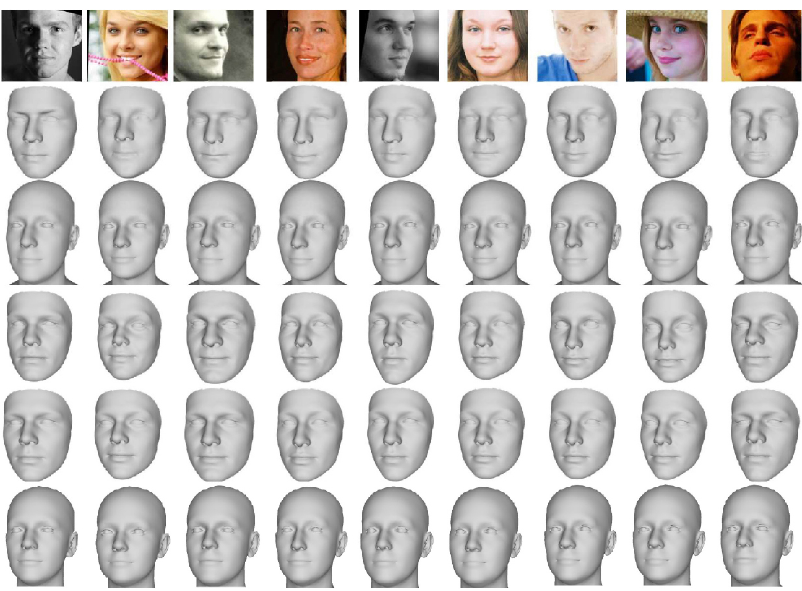
Fig. 9 Some samples of user study. The first row: samples from ALFW2000 dataset. The second row: our results. The third row: the results of RingNet [9]. The forth row: the results of D3FR [34]. The fifth row: the results of MGCNet [72]. The last row: the results of DECA [41].